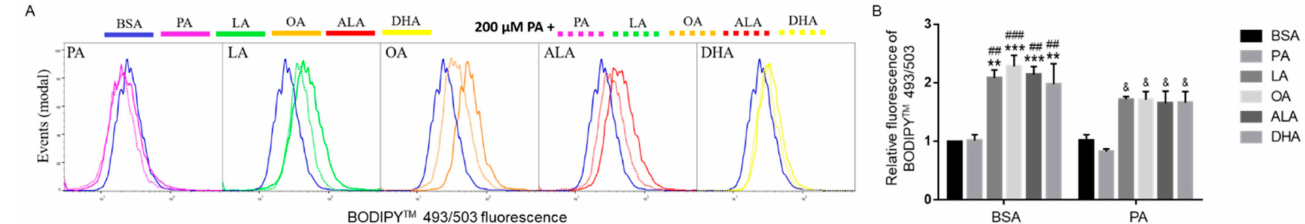
Figure 9. Neutral lipid accumulation in BV2 cells following treatment with BSA or 200 µ M PA together with different FFAs. Cells were treated with BSA or 200 µ M PA together with 200 µ M PA, LA, OA, ALA, or DHA in serum-free media for 6 h. At the end of treatment, cells were incubated with BODIPY TM 493/503 for 30 min followed by flow cytometry analysis of neutral lipid content with representative histograms shown in ( A ) and quantitated data shown in ( B ). Data (mean ± SEM) presented were representative of three independent experiments. Data were analyzed using two-way ANOVA followed by Tukey’s multiple comparison test. ** p < 0.01 vs. BSA control; *** p < 0.001 vs. BSA control; ## p < 0.01 vs. 200 µ M PA; ### p < 0.001 vs. 200 µ M PA; & p < 0.05 vs. 400 µ M